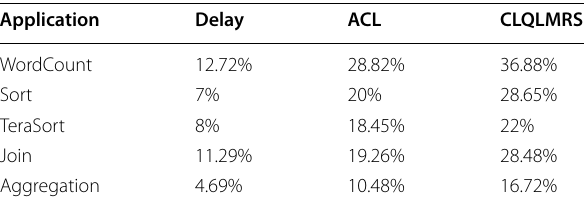
Table 5 The percentage of improvement in different